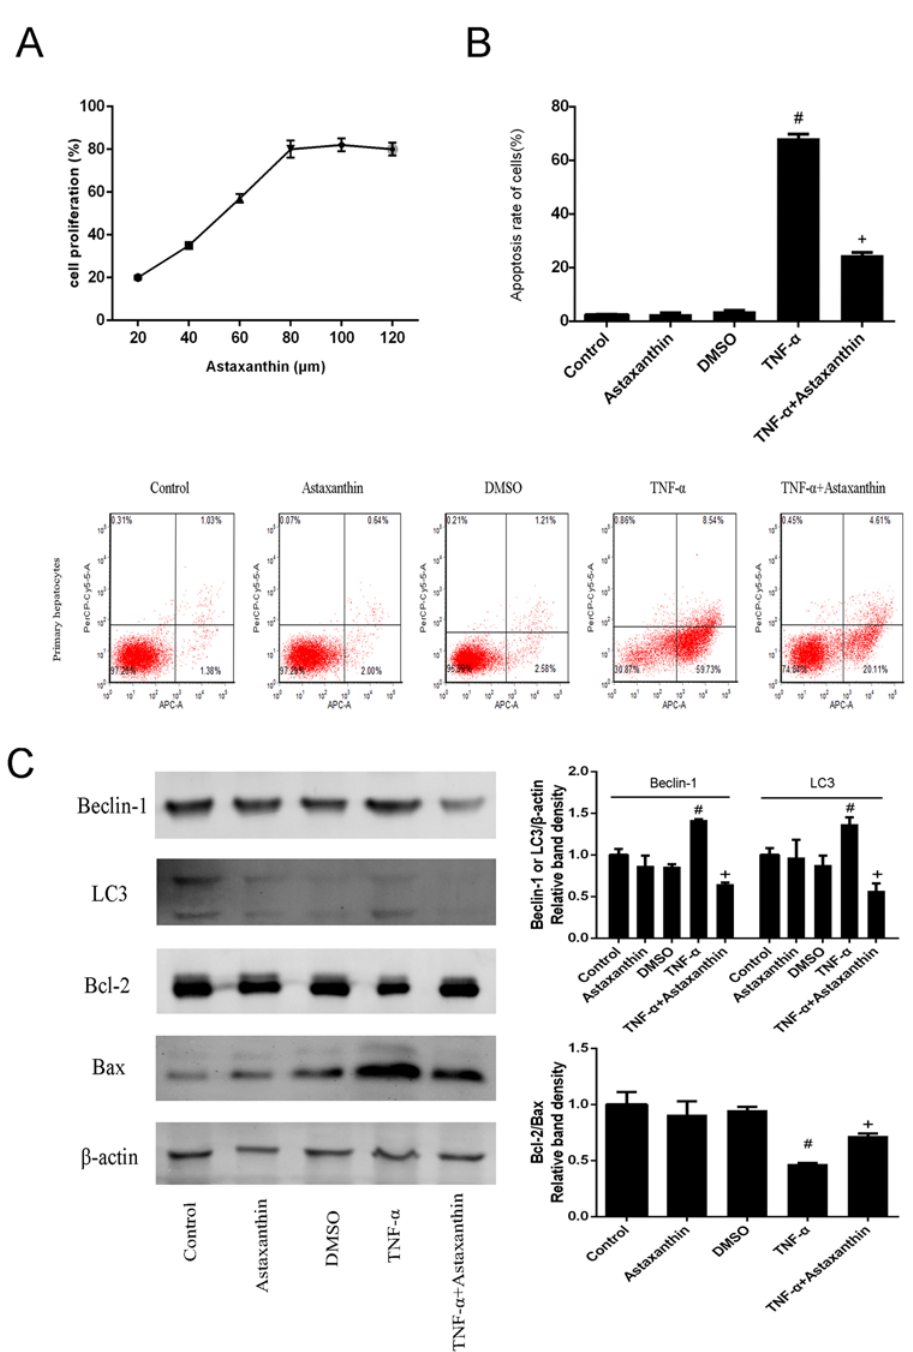
Fig 6. Effects of astaxanthin on the proliferation and apoptosis of primary hepatocytes induced by TNF- α . (A) The proliferation of primary hepatocytes treated with astaxanthin before TNF- α induction was detected with CCK8. (B) The apoptosis of primary hepatocytes was determined with flow cytometry (n = 3, # P < 0.05 for TNF- α versus control, + P < 0.05 for TNF- α +Astaxanthin versus TNF- α ). (C) The protein levels of Beclin-1, LC3, Bcl-2 and Bax proteins in primary hepatocytes are shown as western blot bands. The relative band intensities were calculated (n = 3, # P < 0.05 for TNF- α versus control, + P < 0.05 for TNF- α +Astaxanthin versus TNF- α